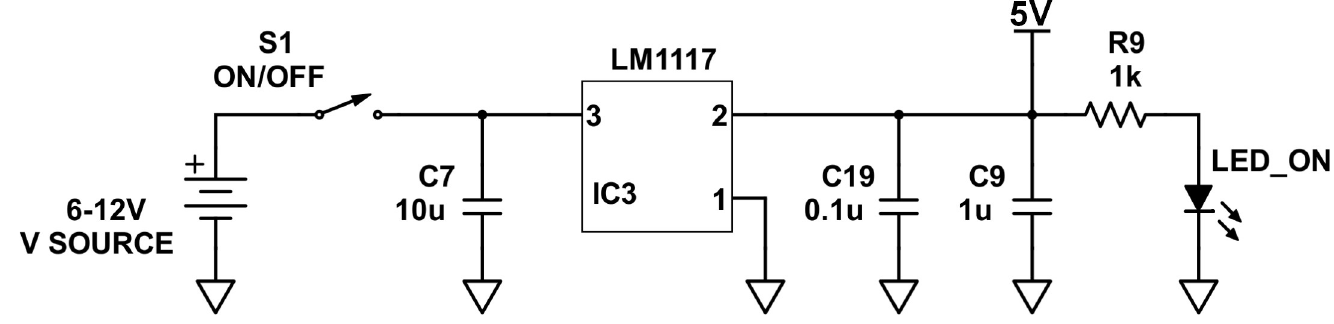
Fig 4. A schematic diagram of the power